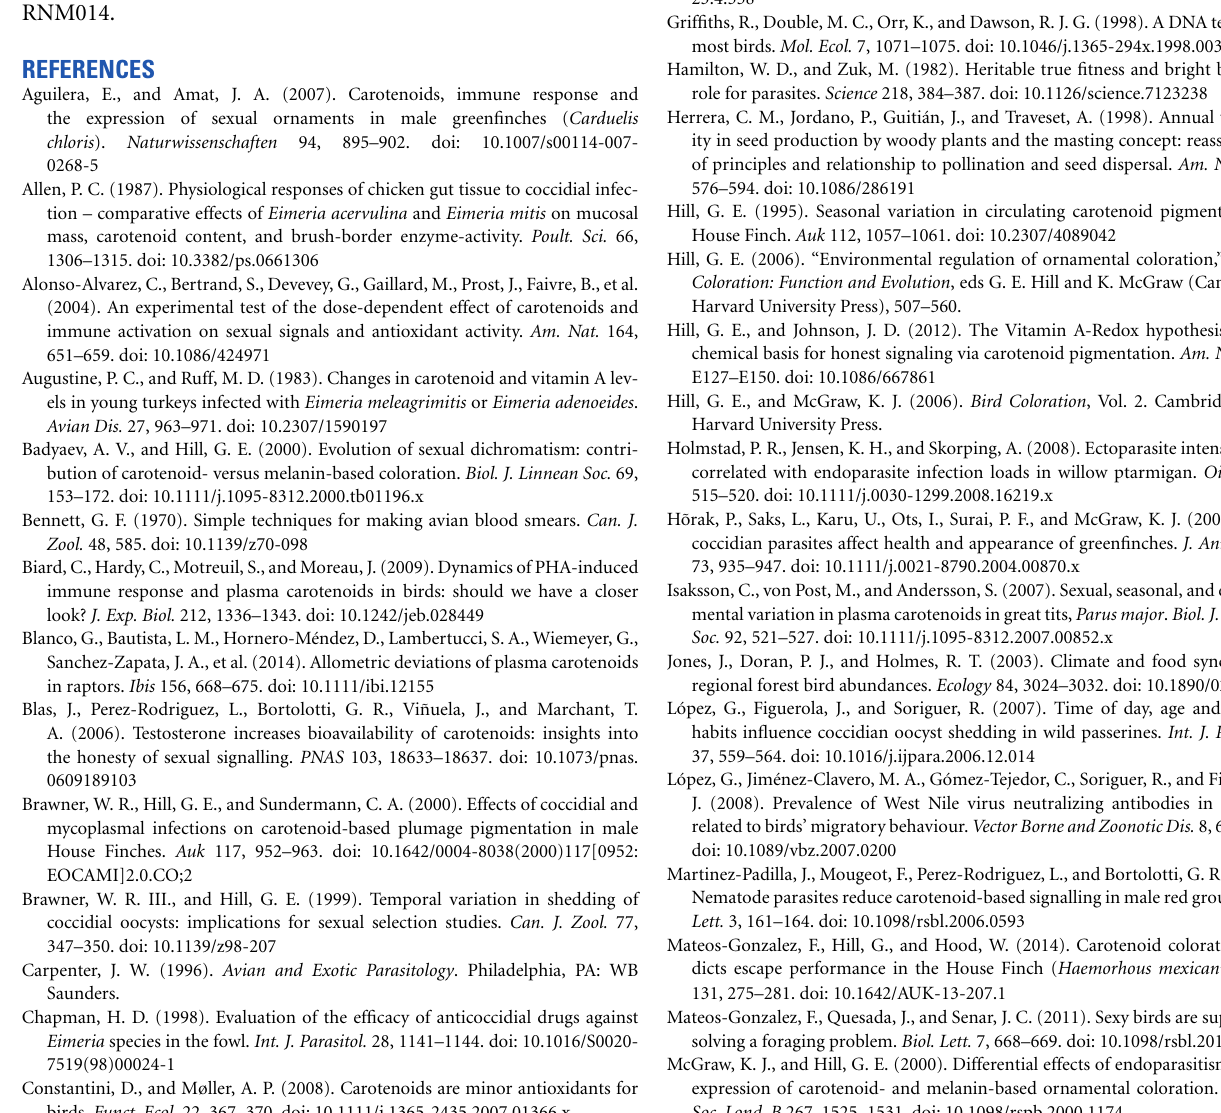
Figuerola, J., and Gutierrez, R. (1998). Sexual differences in levels of blood carotenoids in cirl buntings Emberiza cirlus . Ardea 86, 245–248. Figuerola, J., Muñoz, E., Gutierrez, R., and Ferrer, D. (1999). Blood parasites, leu- cocytesandplumagebrightnessintheCirlBunting, Emberizacirlus .